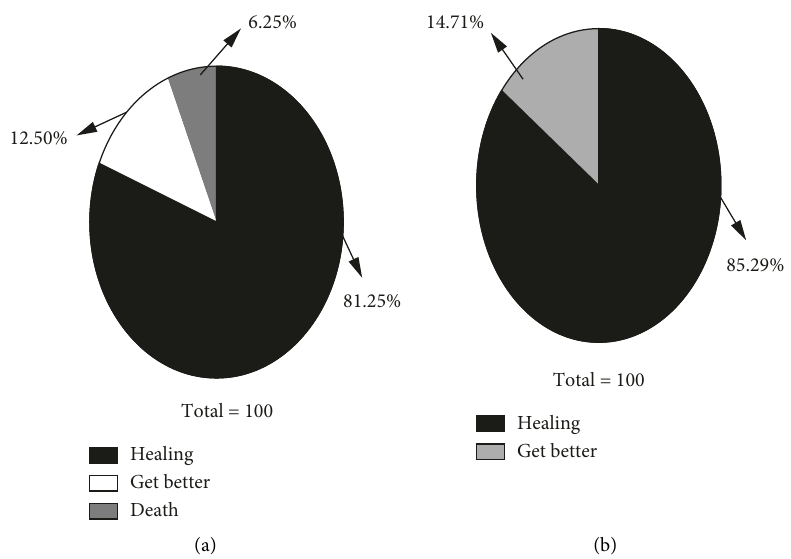
Figure 2: Comparison of clinical outcomes between the two